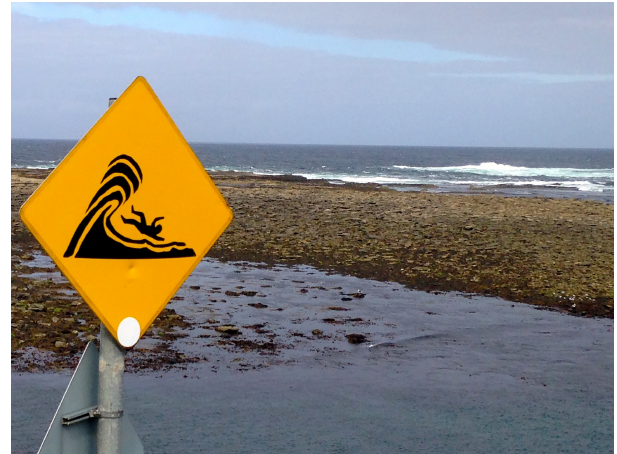
Figure 23. Warning sign at Kilkee, Co.